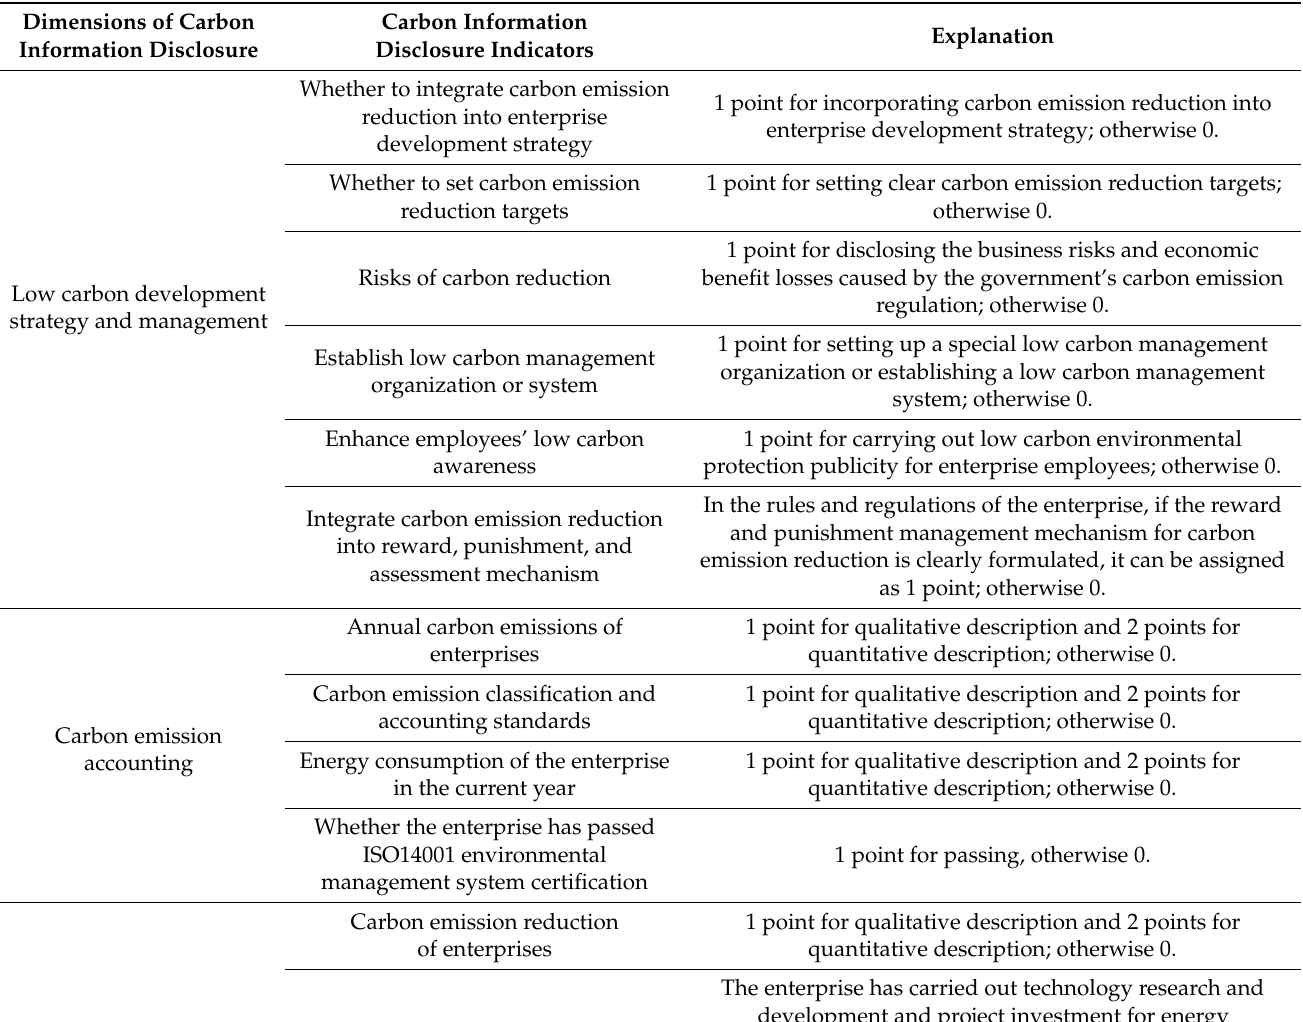
Table 1. Evaluation index of carbon information disclosure